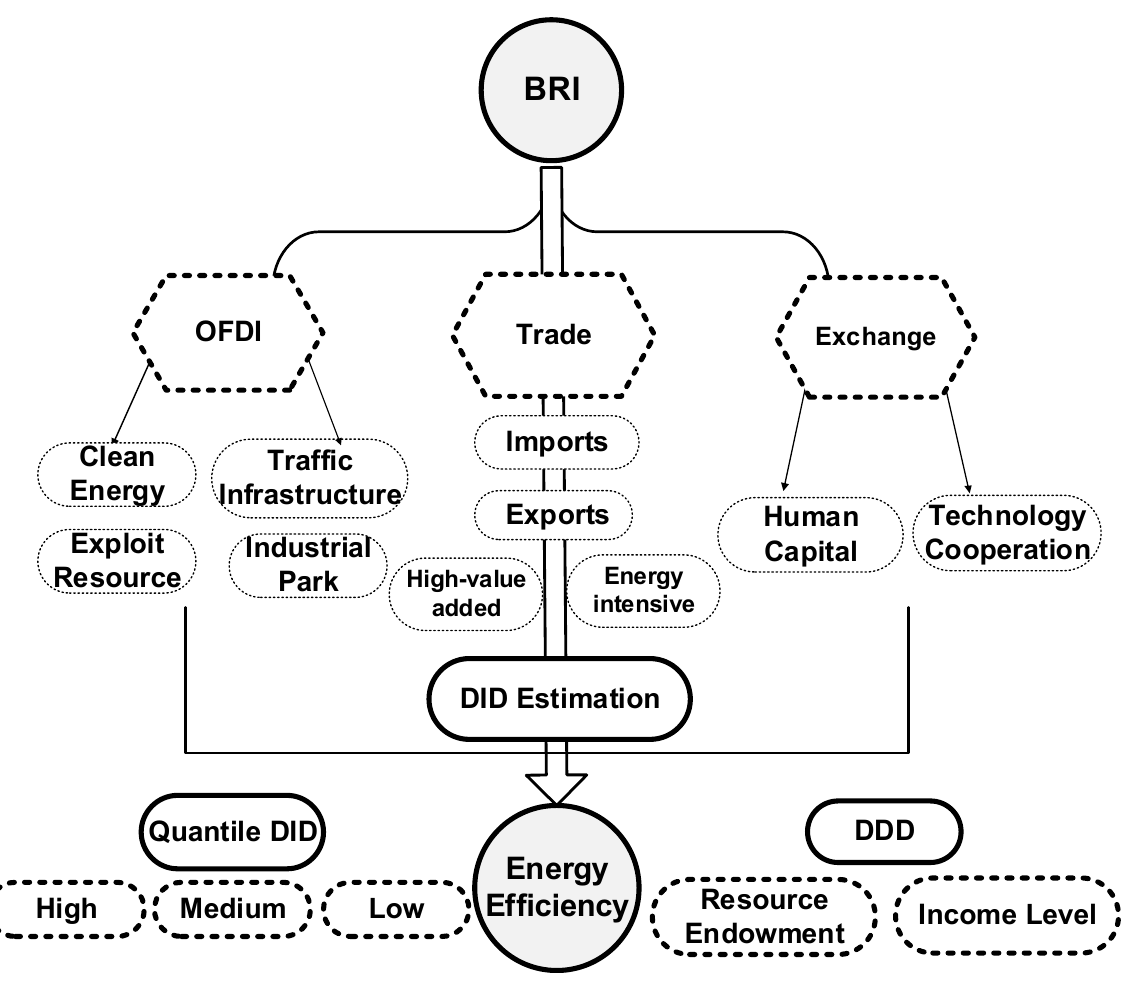
Figure 1. Mechanism and research design.